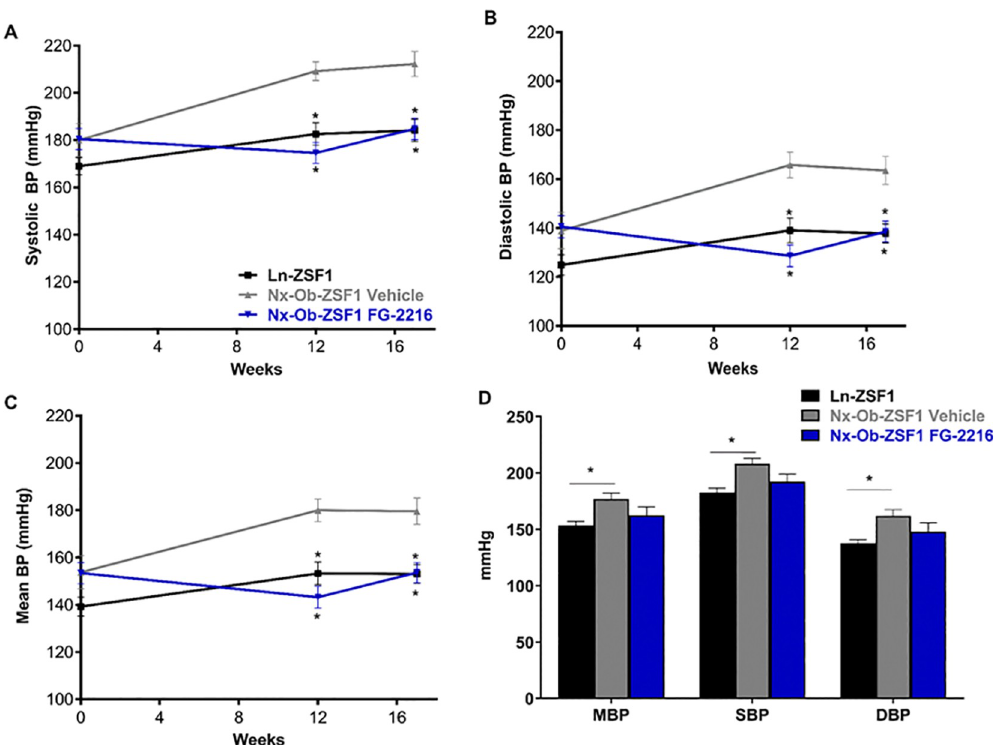
Fig 7. FG-2216 prevented hypertension in Nx-Ob-ZSF1 rats. Systolic ( A ) and diastolic ( B ) blood pressures (BP) were measured and mean BP ( C ) was calculated using a tail-cuff at baseline and three hours after dose administration at 12 and 17 weeks of treatment. Systolic (SBP) and diastolic (DBP) blood pressures were also measured 24 hours following dosing after 17 weeks of treatment and mean BP (MBP) was calculated ( D ). Values represent mean ± SEM (n = 8–12). � P < 0.05 vs . Nx- Ob-ZSF1 Vehicle (Bonferroni test).